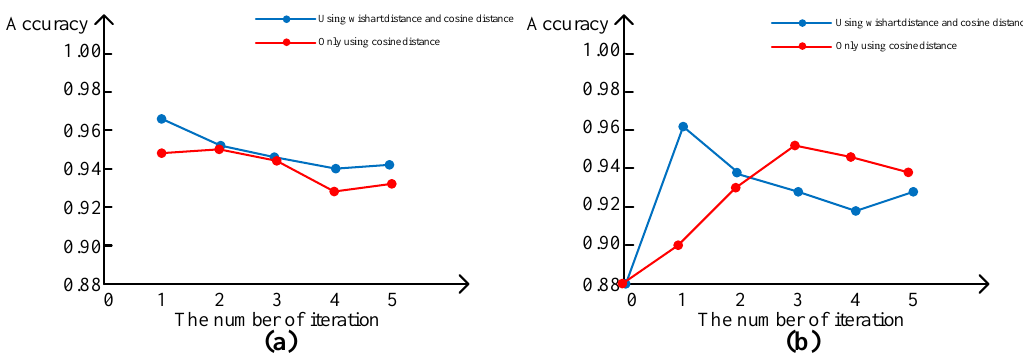
Figure 6. ( a ) Accuracy of label propagation during the iteration. ( b ) Accuracy of classification during the iteration.